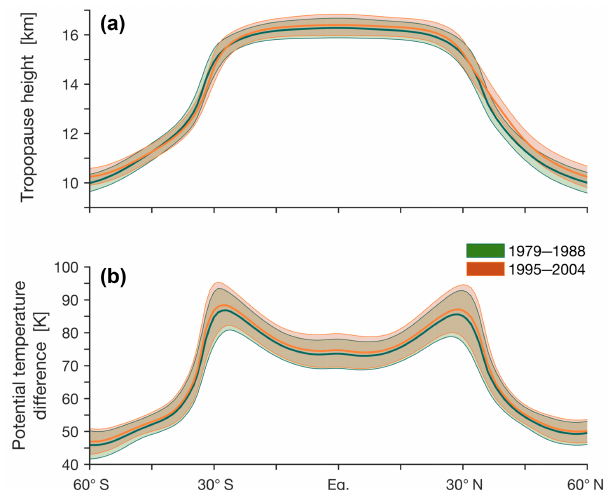
Figure 4. The mean tropopause height ( a ) and the difference in the potential temperature between the tropopause level and the surface ( b ) during the decades beginning in 1979 (green) and 1995 (orange) in CMIP5 models. The shading indicates ± 1 standard deviation of inter-model spread. The calculations are derived from monthly means of the temperature